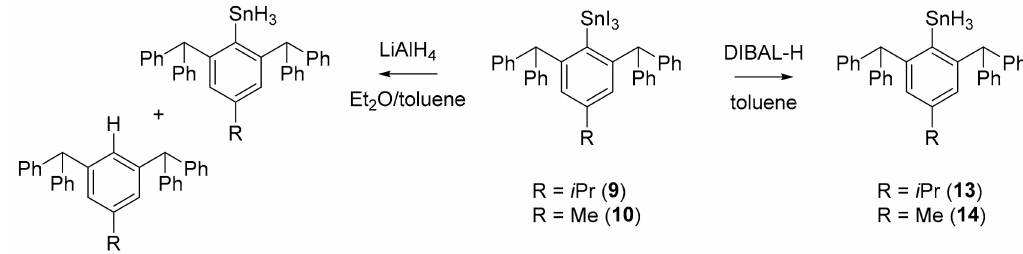
Figure 5. Hydrogenation of aryltin triiodies 9 and 10 with LiAlH 4 leads to a mixture of the corresponding hydride and hydrolyzed ligand. Using a softer hydride transfer reagent like DIBAL-H gives access to 13 and 14